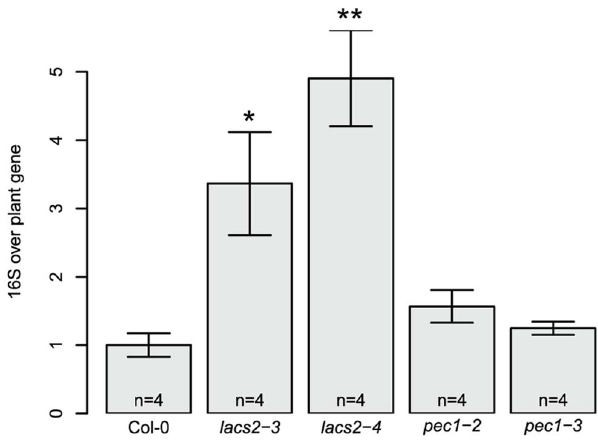
Figure 4. Higher 16S rRNA gene copy numbers were found for the lacs2 mutant compared to the wild-type plants. The number of 16S rRNA gene copies was normalized using a plant gene AT4G33380 and normalized to the wild-type. The number of DNA pools analyzed for each genotype is indicated in the barplot. Asterisks indicate a significant effect for genotype compared to Col-0 (*, P , 0.05; **, P , 0.01; Student’s t-test, Bonferroni- adjusted P values). These experiments were repeated at least in triplicate with similar results. 1, and RRS-7, were confirmed in independent replicate experi- ments (Figure 5A). Multivariate analysis of variance confirmed a significant effect of each genotype on community composition (Table 2 and Table S3). Statistical tests revealed that there was a genotype effect for the RFI of Arthrobacter (lower in Mr-0), M. extorquens PA1 (higher in RRS-7), M. radiotolerans (higher in Ler and RRs-7), and Sphingomonas sp. Fr1 (lower in Ct-1, Ler and RRS-7. In addition, bacterial abundance was also different on the natural accessions as indicated by quantitative qPCR of the 16S rRNA gene (Table 2 and Table S4). The 16S rRNA gene copy numbers were higher on Mr-0 and lower on Ler, Ct-1, and RRS-7 (Figure 5B).